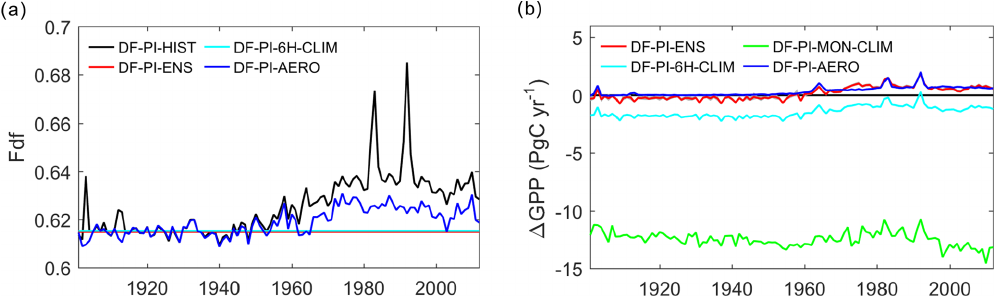
Figure 2. Time series of (a) global mean Fdf and (b) (cid:49) GPP between DF-HIST and no-anthropogenic-aerosol scenarios. The DF-PI-MON- CLIM has the same mean Fdf as DF-PI-6H-CLIM and thus is not shown in (a) . The shaded area along the red curve in (b) indicates the range of the three ensemble members of the DF-PI-ENS simulations.